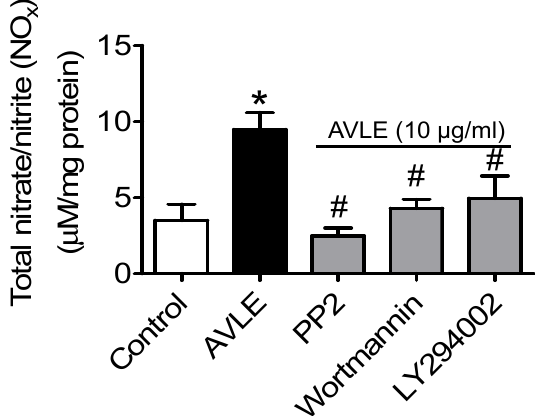
Figure 2. AVLE at 10 µ g/mL increased NO production in rat aortas. The NO released induced by AVLE was markedly decreased by inhibitor of Src kinase, PP2 (20 µ M) and PI3-Kinase inhibitors, wortmannin (30 nM) and LY294002 (20 µ M). Results are means ± SEM ( n = 5–6). * p < 0.05 compared to control, # p < 0.05 compared to AVLE.